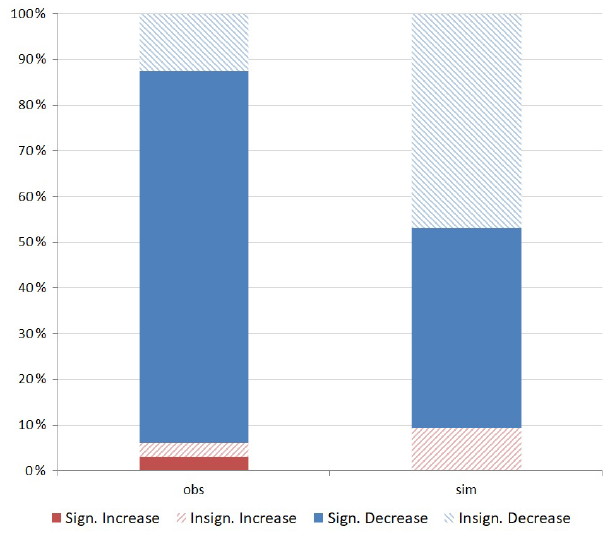
Figure 7. Percentage of sites where statistically significant upward trends (dark red), non-significant upward trends (hatched dark red), significant downward trends (dark blue), and non-significant down- ward trends (hatched dark blue) were obtained for PM 10 observa- tions and simulated